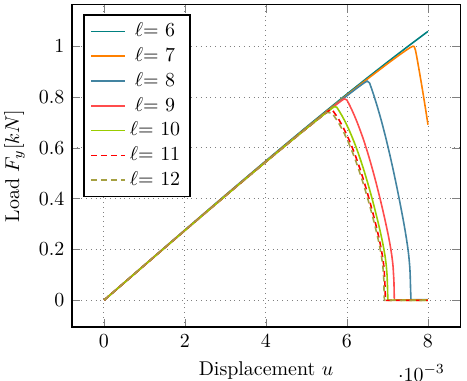
Figure 3. Refinement studies for the single-edge notched tension test using Miehe splitting. All other parameters are fixed. In particular, ε is set to ε = 4 × 10 − 3